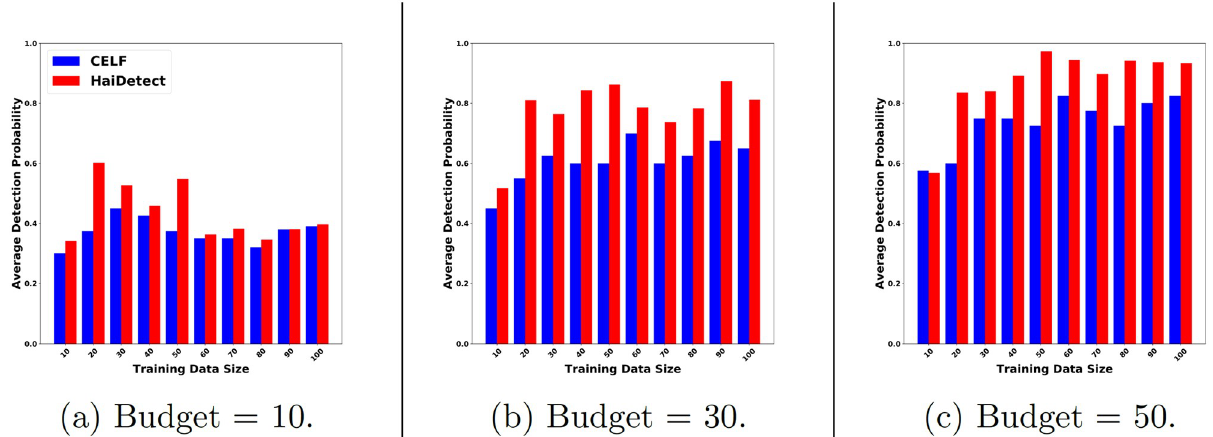
Fig 7. Average probability of detecting future outbreaks for sensors computed using T simulations (training) for different values of T, and tested on the remaining simulations for a budgets of (a) 10, (b) 30, and (c) 50. Note that H AI D ETECT required only 20 simulation instances to detect future outbreak with probability of